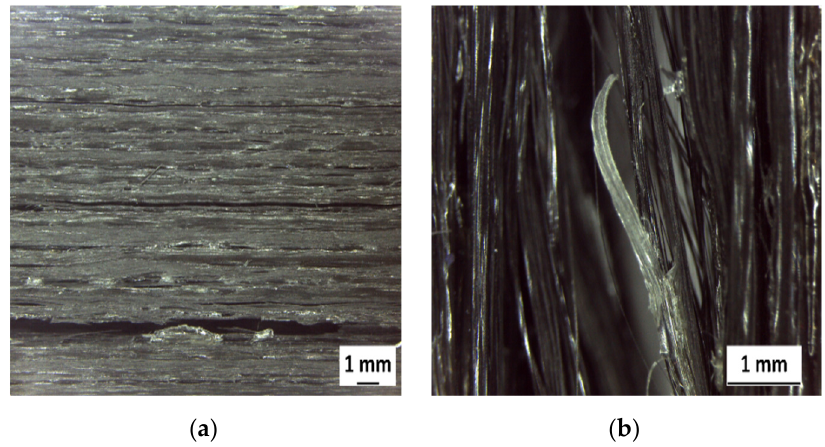
Figure 15. ( a ) Fracture surface of continuous raw FRP, 0°; ( b ) fracture surface of raw continuous FRP, 90 ° .